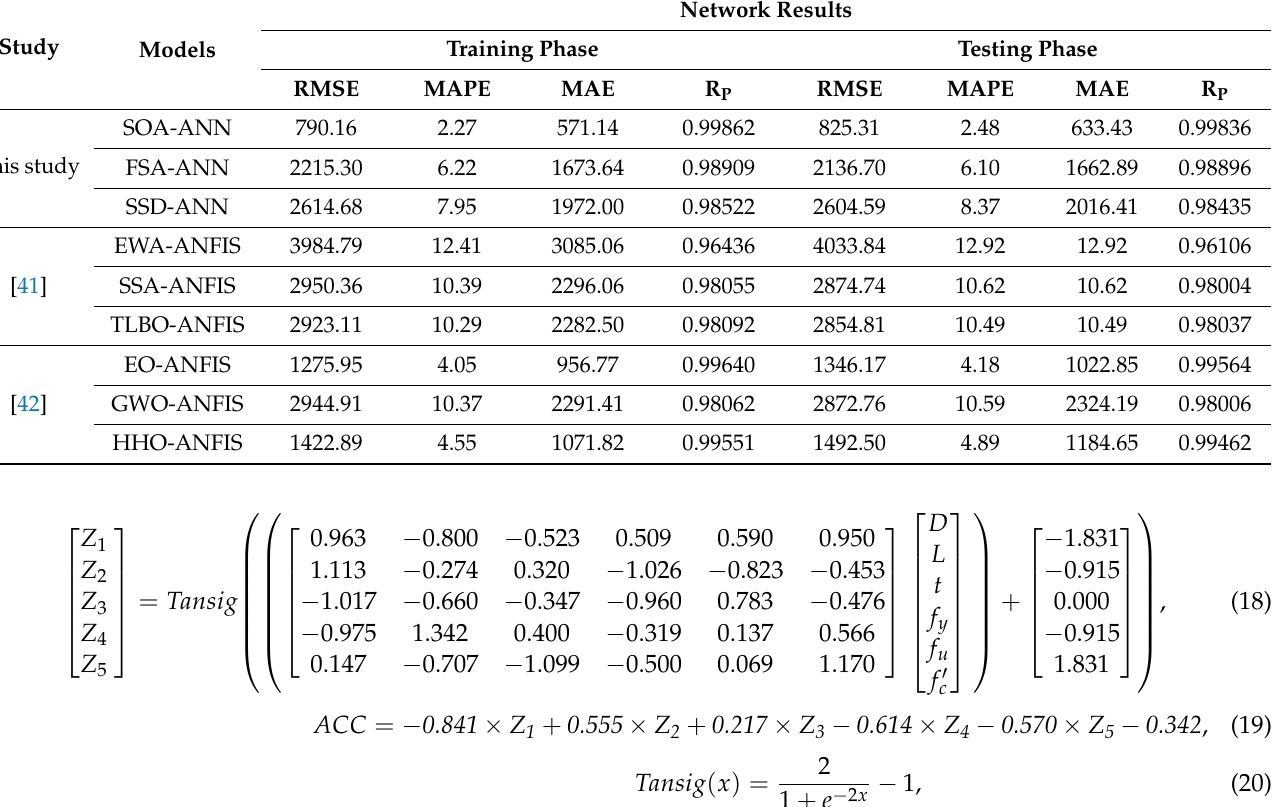
Table 2. Computed values of RMSE, MAE, MAPE, R P in this study and previous